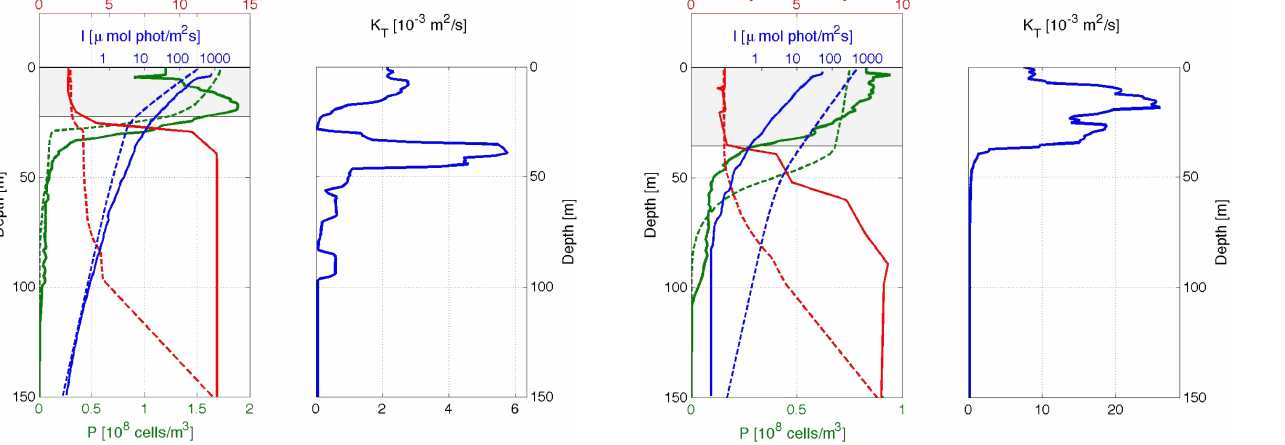
Figure 6. Measurements (solid lines) and model results (dashed lines) at the northern station. Left panel: phytoplankton concentra- tion (green), nutrient concentration (red) and light intensity (blue). The LSM is based on the mean phytoplankton concentration and the mean nutrient concentration in the ML (grey area). Right panel: vertical mixing coefficient K T .